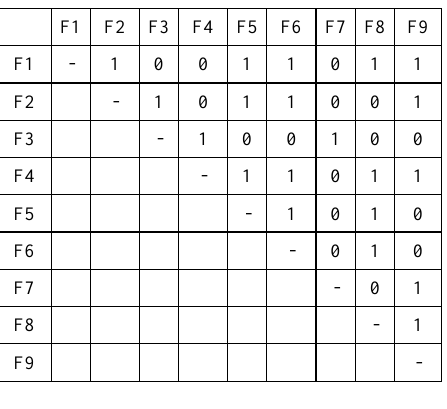
Table 8. Suitable situations among the facilities (0-represents the negative situation, 1 represents